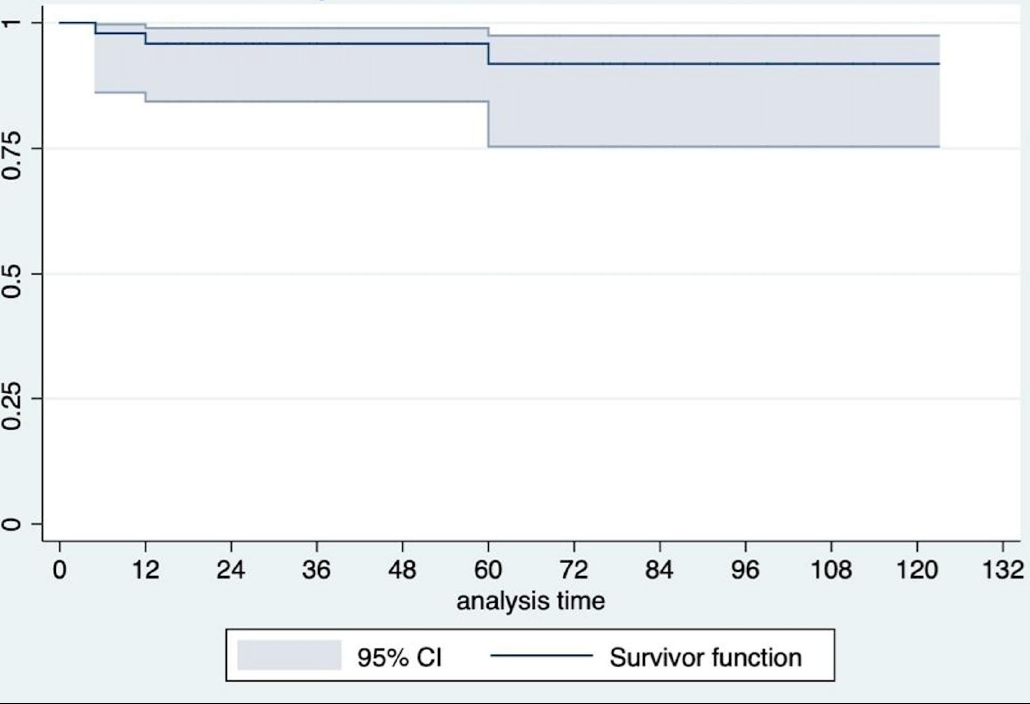
Figure 8. Kaplan–Meier overall erosion ‐ free survival curve.